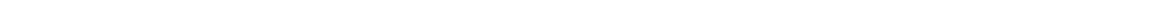
Fig. 1 SIVagm constructs expressing functional Vpu and HIV-1 Nef. a Genomic organization of the WT SIVagm construct with the nef gene (yellow) and the GU1N derivative containing the SIVgsn vpu (blue) and the HIV-1 NA7 nef (orange). b HEK293T cells were cotransfected with a vpu -deleted HIV-1